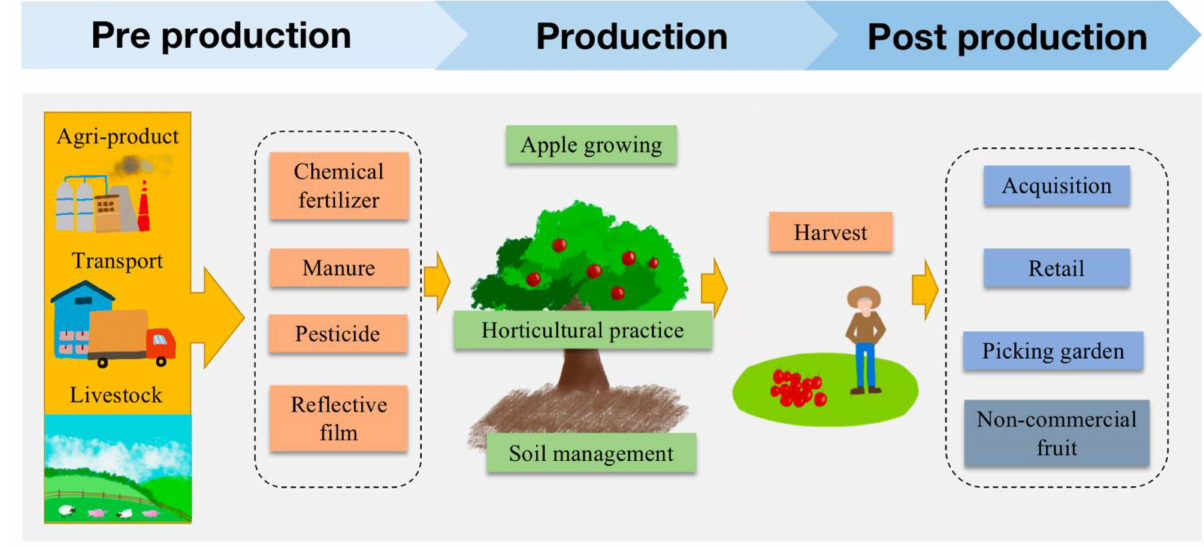
Figure 1. Research framework and system